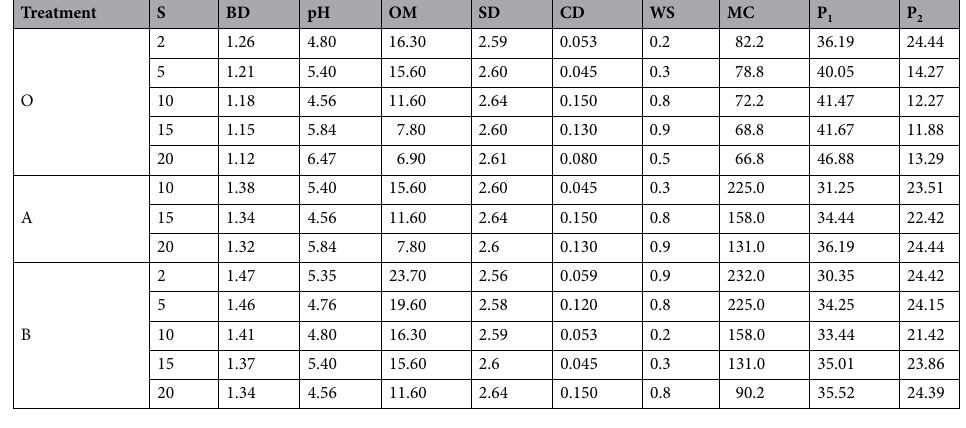
Table 2. Soil property indicators of sample plots. S is Slope ( o ),BD is soil bulk density(g/cm 3 ), OM is organic matter(g/kg), SD is soil particle density(g/cm 3 ), CD is electrical conductivity(ds/m), WS is water-soluble salt content(g/kg), MC is microbial carbon(mg/kg), P 1 is > 2 mm soil particle content(%), P 2 is < 0.002 mm soil Particle content(%). O is bare slope, B is Prunella vulgaris combined with earthworm planting slope, A is Single planting prunella vulgaris slope.